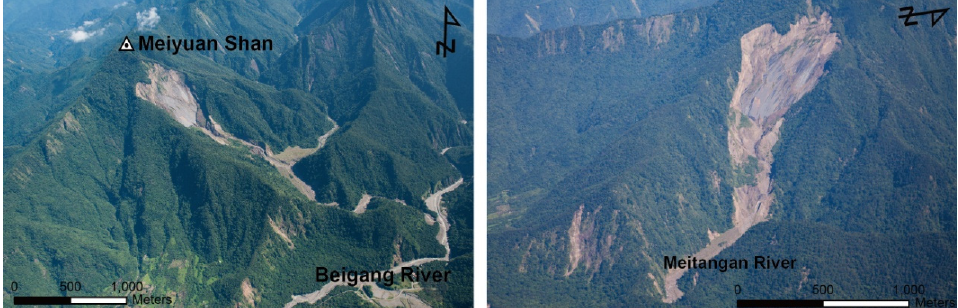
Figure 2. Panorama of the Meiyuan Shan landslide. The left image, a view from the south of Meiyuan shan, illustrates that the Meiyuan shan terrain along the northeast–southwest direction is a dip slope. It also shows the alluvial fan generated by rock slides and debris flows. The Meitangan River feeds into the Beigang River, the main river in this area, which is shown at the right side of this image. The right image, a view from the east of the Meiyuan Shan landslide, displays the relatively smooth surface of the zone of depletion revealed after the landslide. A large body of rock and sediments can still be clearly observed at the foot of the slope.